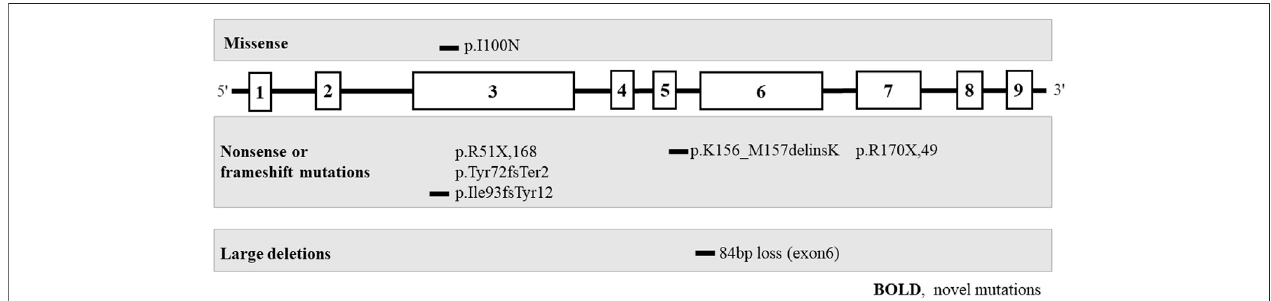
FIGURE 3 | Pathogenic variants of the HPRT1 gene (bold, novel mutation) in eight unrelated Chinese families with Lesch-Nyhan disease. Most are private genetic variants, p. R51X,168, which were con fi rmed in two families.